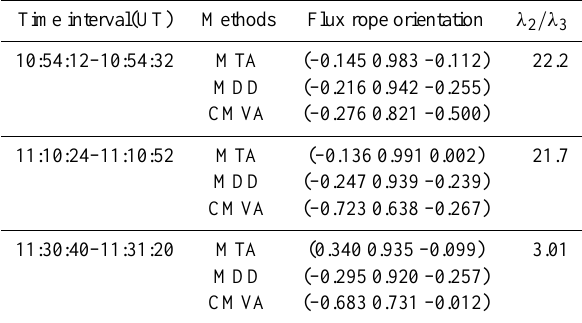
Table 2. MTA results of three flux ropes observed on 26 January 2001, along with the comparison with other